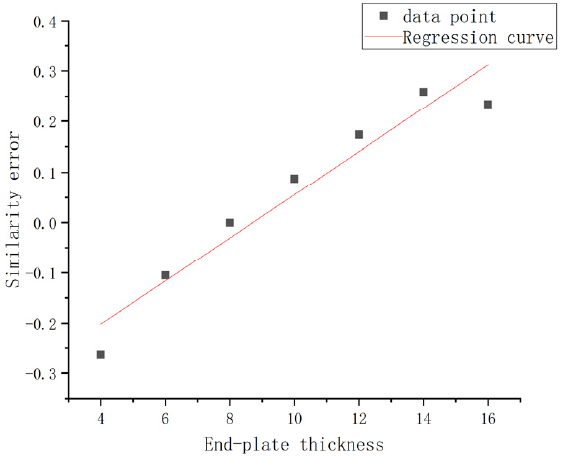
Figure 25. Data points and the regression curve at B f .